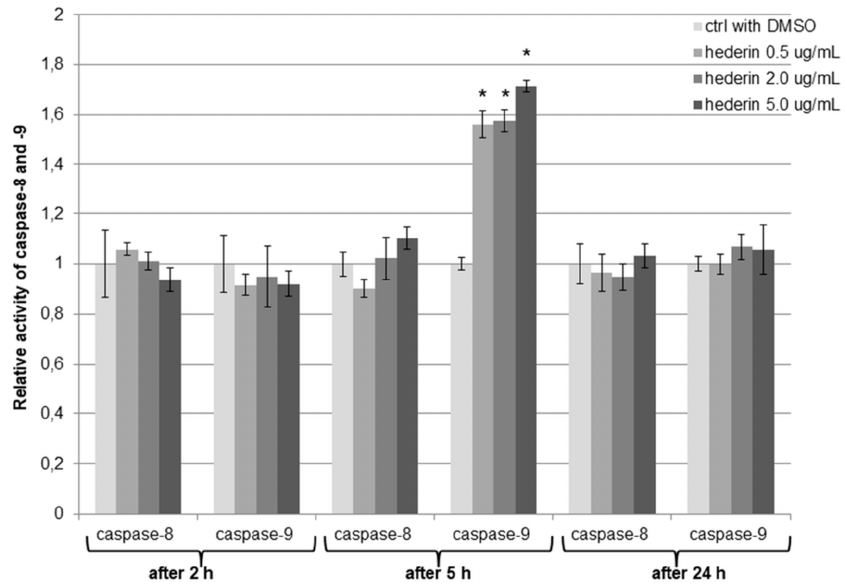
Figure 8. Caspase-8 and caspase-9 activity after the SKOV-3 cells’ treatment with α -HN. A significant increase was observed in caspase-9 activity in the SKOV-3 cell line after 5 h of incubation with different concentrations of α -HN in comparison to the control (0.3% DMSO-treated cells). Each sample was run three times, independently. Error bars represent standard deviations. Significant differences relative to the DMSO control are marked with * ( p < 0.05). Molecules 2019 , 24 , x FOR PEER REVIEW